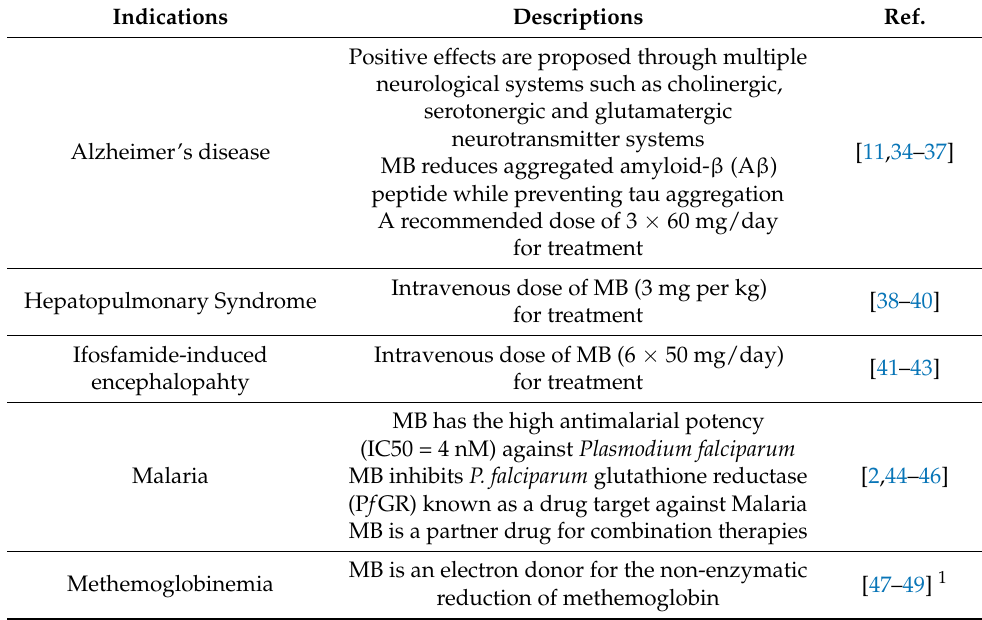
Figure 1. Chemical structure of methylene blue. Table 1. Examples of clinical use of methylene blue (MB).